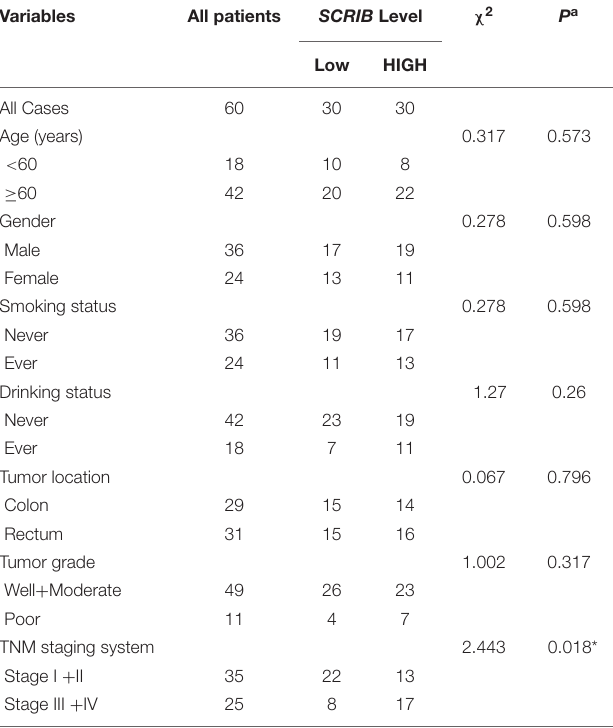
TABLE 1 | Relevance analysis of SCRIB expression in CRC